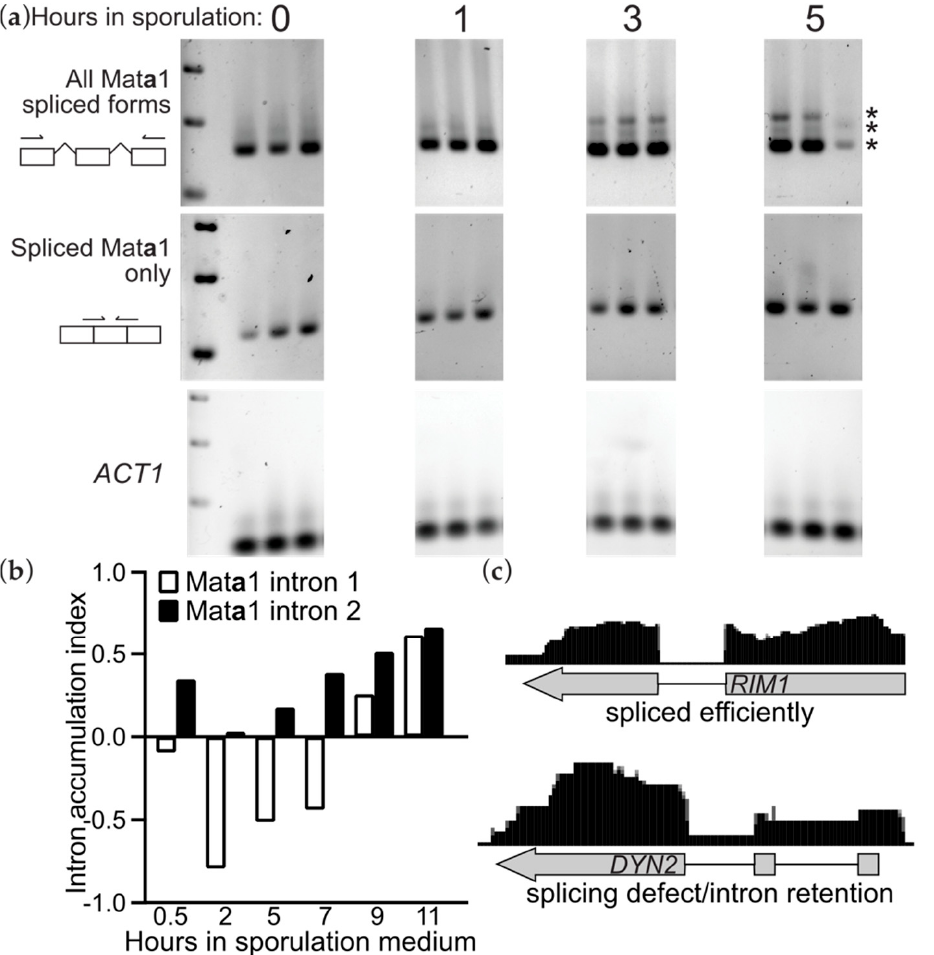
Figure 3. Intron retention in Mat a 1 transcripts reflects a widespread splicing defect. ( a ) RT ‐ PCR was used to detect Mat a 1 transcripts in total RNA isolated from cells of strain FY2740 undergoing syn ‐ chronous sporulation. Three biological replicates were analyzed for each sample. The left ‐ most lane is a molecular weight marker (SM0311, Thermo ‐ Fisher) showing bands of 750, 500, and 250 base ‐ pairs. Illustrations to the left show where the Mat a 1 primers anneal and how they allow detection of all spliced forms or fully ‐ spliced Mat a 1. Asterisks at right mark the three spliced forms. ( b ) Pub ‐ lished microarray data [27] showing Mat a 1 intron retention in cells undergoing synchronous spor ‐ ulation. ( c ) From our RNA ‐ seq data, examples of a transcript that was spliced efficiently in spores— as indicated by a lack of reads mapping to the intronic sequence—and a transcript that showed, like Mat a 1, intron retention. See Table 1 for a list of other transcripts and their intron retention in spores. Table 1. Intron retention in spore transcripts. RNA ‐ seq reads from sorted spores were analyzed for 90 intron ‐ containing genes to classify them as to the efficiency of their splicing in spores. The num ‐ ber of genes in each splicing efficiency category is given in parenthesis.